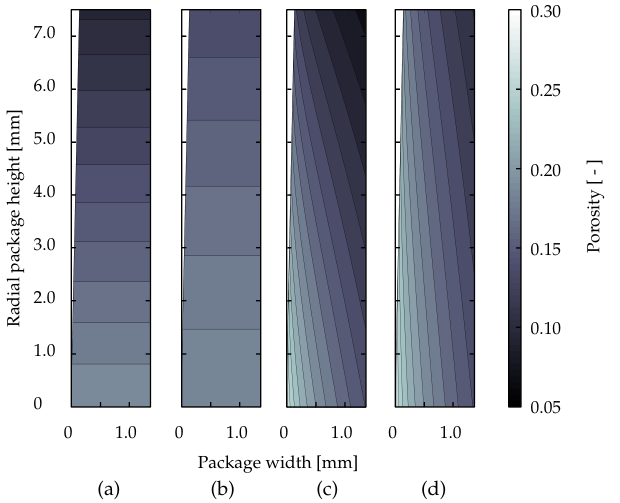
Figure 3. Distribution of porosity (cid:101) in the bristle package with consideration of: ( a ): width, ( b ): radius, ( c ): width + ax. compression, and ( d ): width + radius + ax.